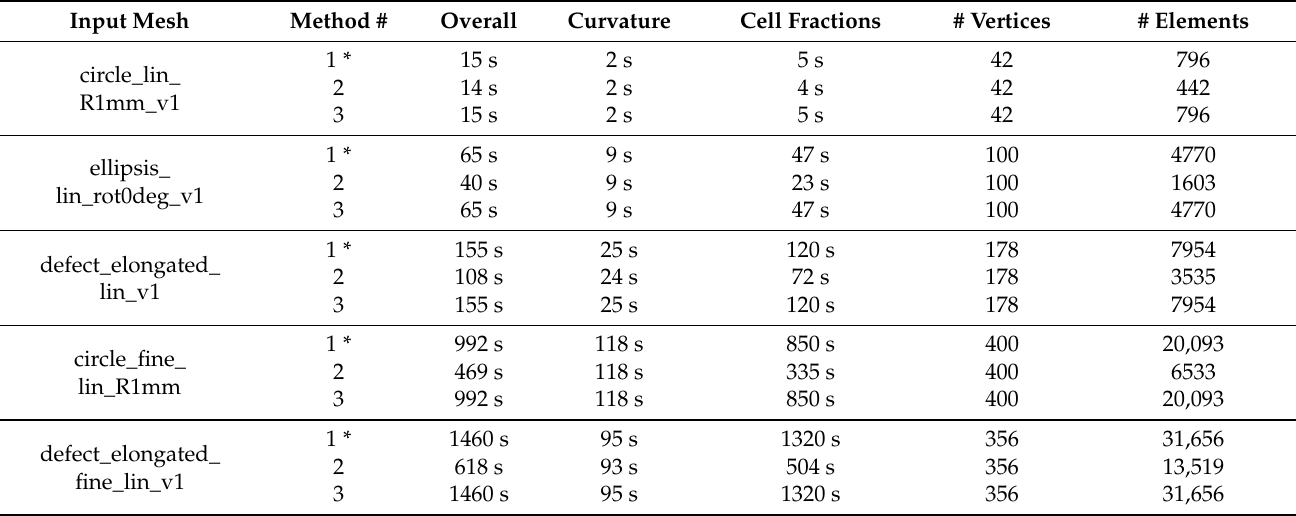
Table 10. Measured computational effort for pre-processing of the three characteristic defect geome- tries using single-core processing for one load vector ( ϕ = 0 ◦ ).